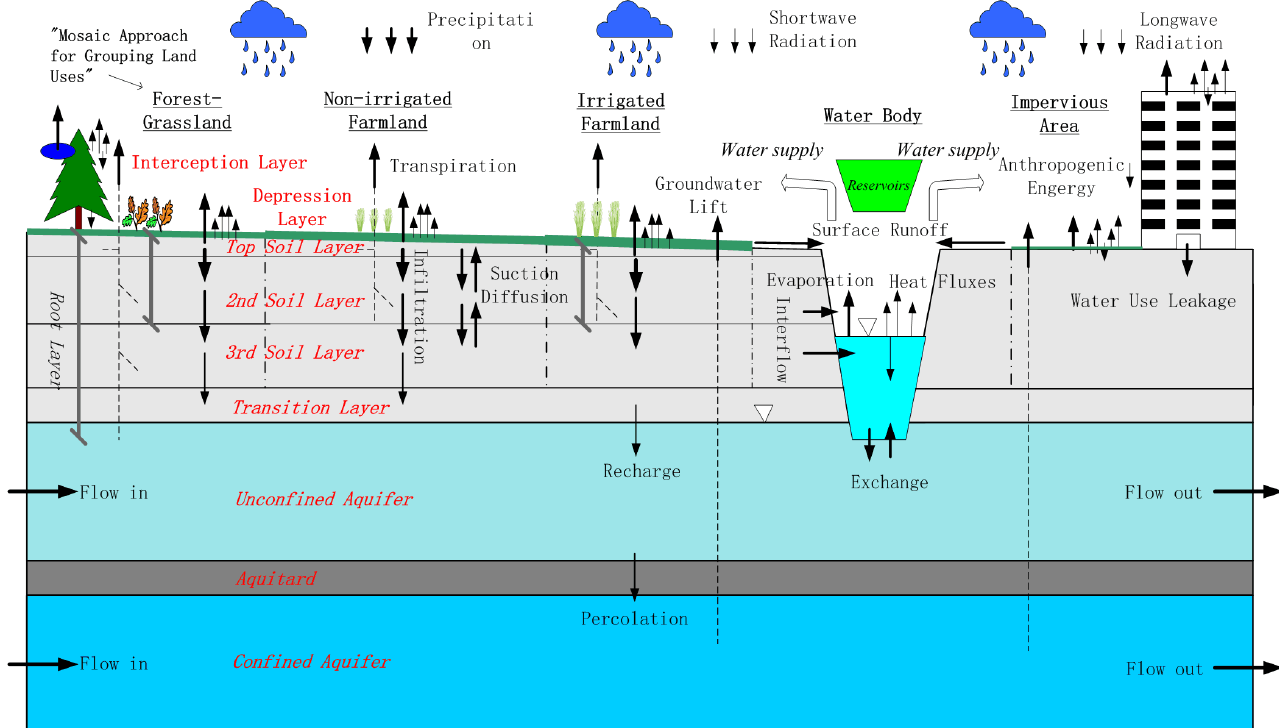
Figure 4. Vertical structure of the WEP-L